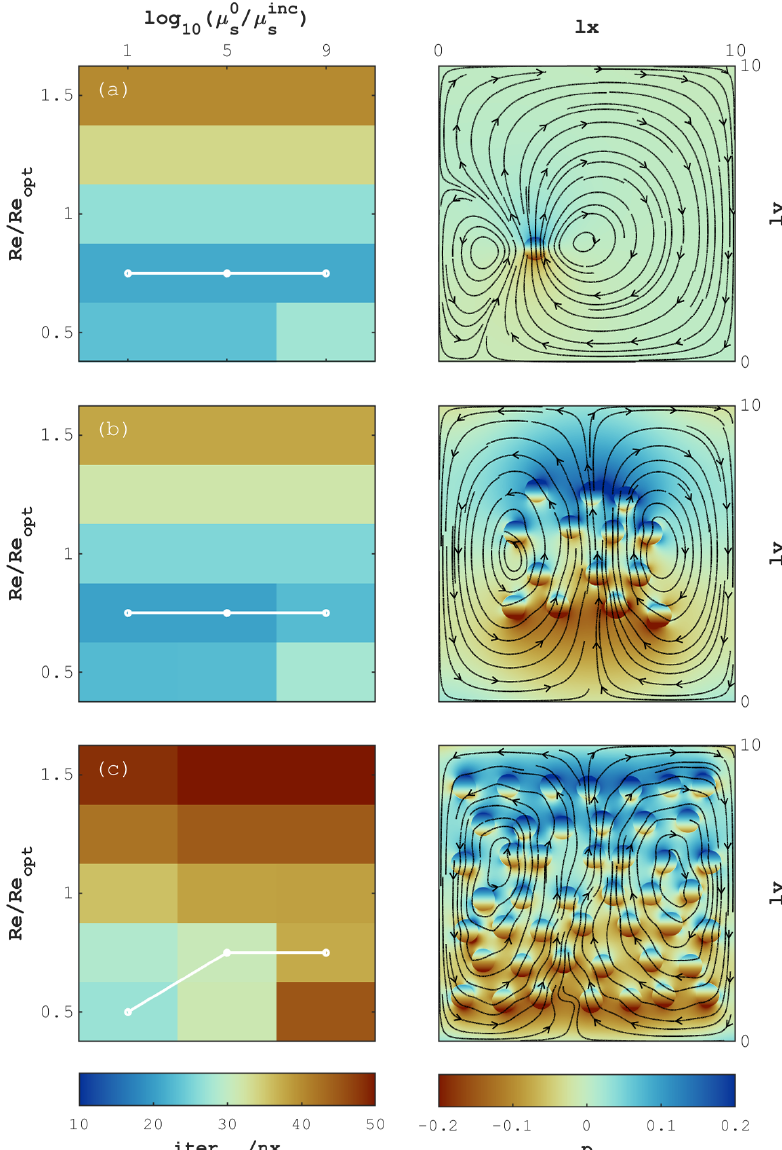
Figure 13. Buoyancy-driven flow. The left column reports the number of iterations for different values of viscosity ratio µ 0 s /µ inc s and ratio of numerical Reynolds number Re to the theoretically predicted value Re opt . Connected white dots indicate the value of Re at which the minimal number of iterations is achieved. The right column depicts the deviation of pressure from hydrostatic distribution and velocity streamlines. Panels (a) , (b) and (c) correspond to problem configurations involving 1, 14 and 46 inclusions, respectively.